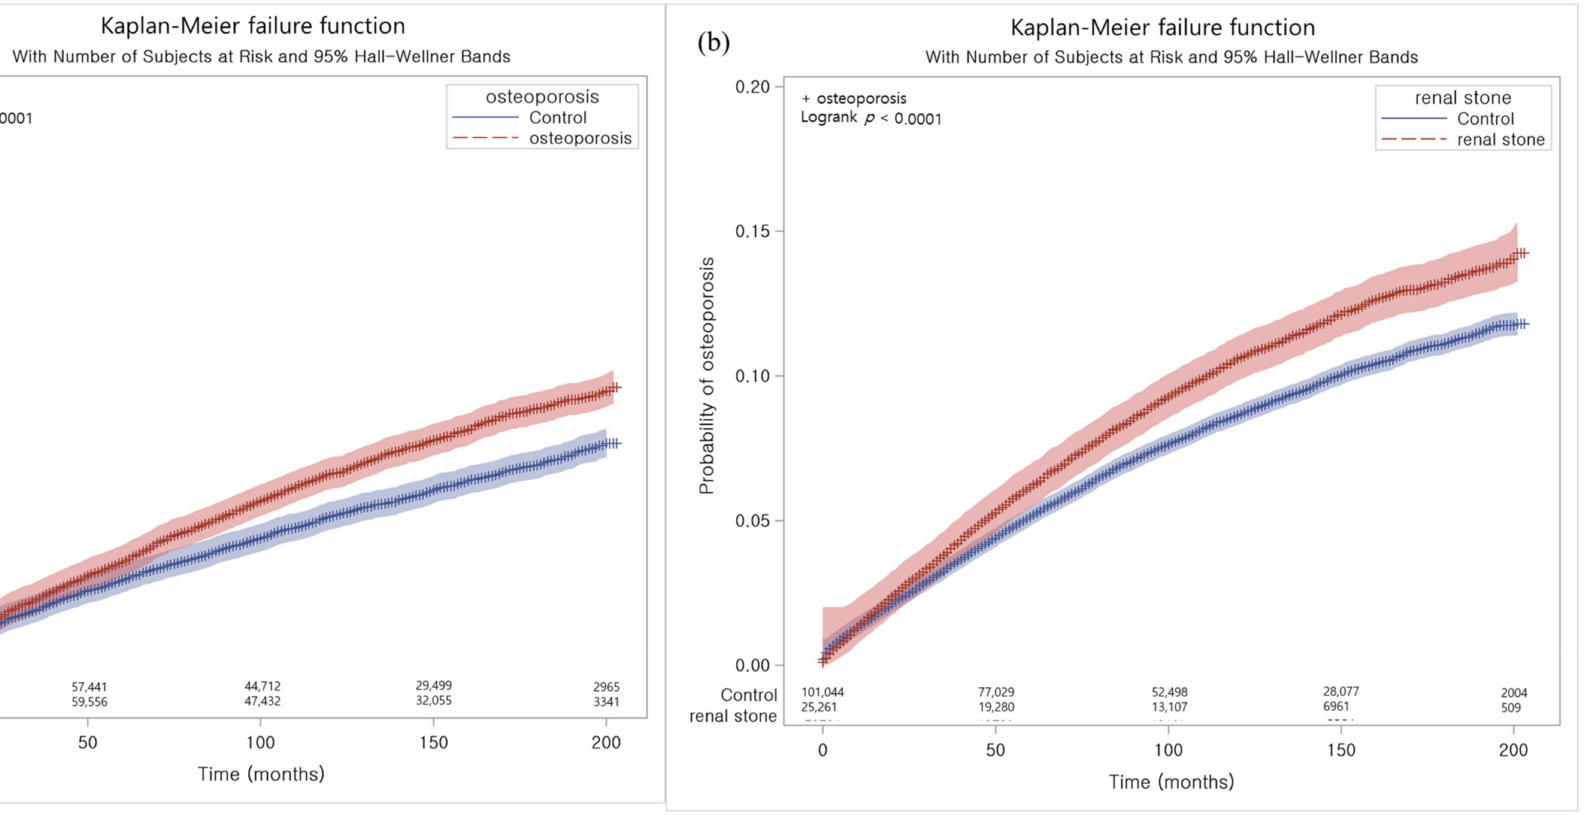
Figure 2. ( a ) The Kaplan–Meier method was applied in study I. The rate of renal stones was significantly higher in the osteoporosis group than in the control I group. ( b ) The Kaplan–Meier method was applied in study I. The rate of osteoporosis was significantly higher in the renal stone group than in the control II